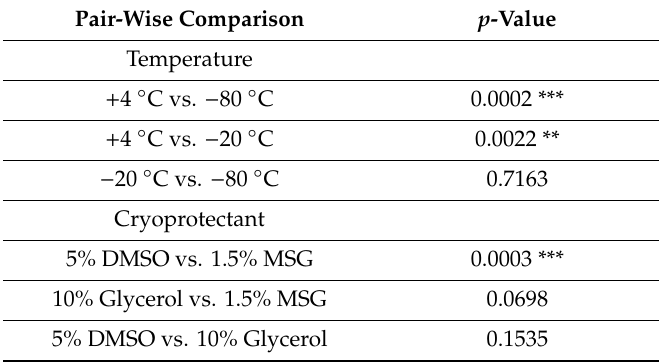
Figure 4. The change in M. bovis BCG total viable counts (cube root-transformation CFU mL − 1 ), between fermenter culture samples that were exposed to different storage conditions and stored for 24 h. Shown here, is the effect of each condition on the change in M. bovis BCG total viable count and the interaction effects between combinations of two different conditions (white boxes). Starting titers prior to storage were 2.77 × 10 9 (±4.41 log 10 CFU mL − 1 ) and 3.60 × 10 9 (±2.64 log 10 CFU mL − 1 ) for culture in Middlebrook and Roisin’s, respectively. Error bars represent standard error on the mean average of three culture replicates. ‘***’ p = 0.001, ‘**’ p = 0.01 ‘*’ p = 0.05. Table 1. The p -values of pair-wise comparisons for individual conditions (e.g., − 20 ◦ C, − 80 ◦ C, or + 4 ◦ C) within each parameter (e.g., temperature) that were determined to be significant by factorial ANOVA. The pair-wise comparisons were generated by a post-hoc Tukey’s HSD Test on cube-root transformed CFU mL − 1 ; the condition that is most favorable for retention of total viable counts is the first condition of each comparison.